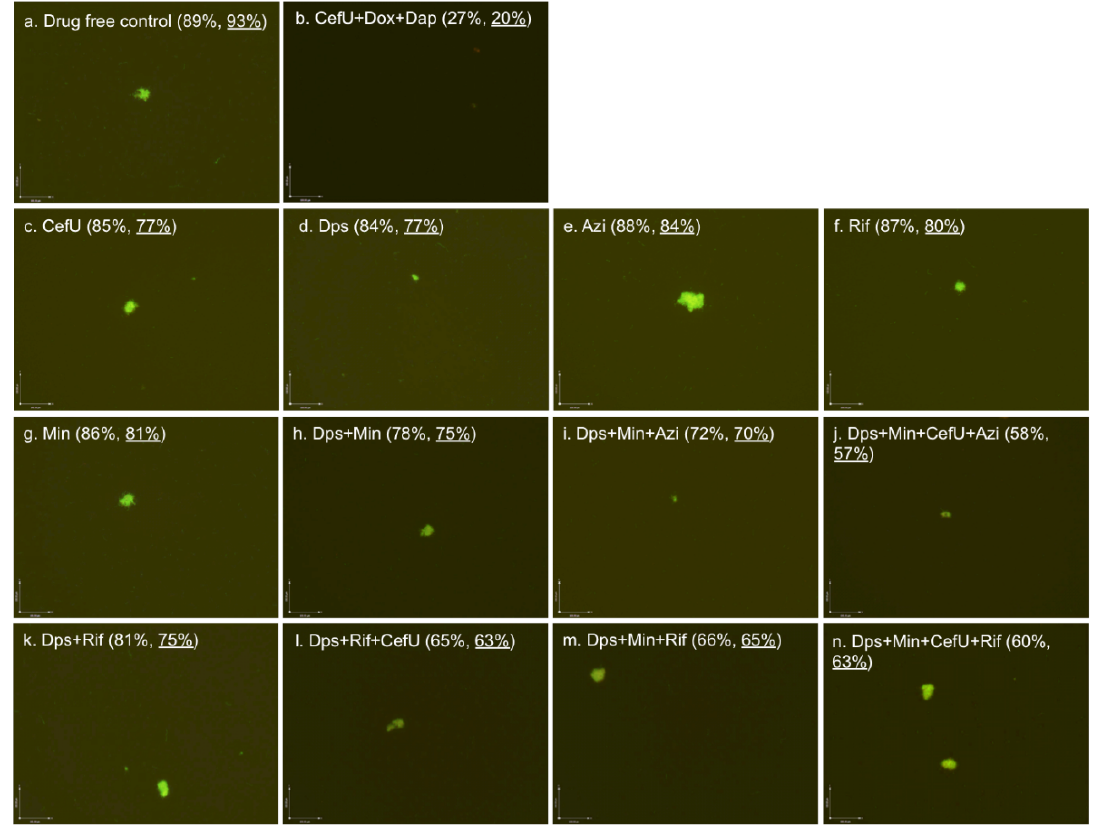
Figure 2. Effect of antibiotics alone or in combinations on stationary phase B. burgdorferi culture. A seven-day-old B. burgdorferi stationary phase culture was incubated with the indicated drugs or drug combinations at a final concentration of 5 µ g/mL for each antibiotic for seven days, followed by SYBR Green I/PI staining and epifluorescence microscopy (100 × magnification). The calculated percentage and direct counting percentage (underlined) of residual viable cells are shown in brackets.